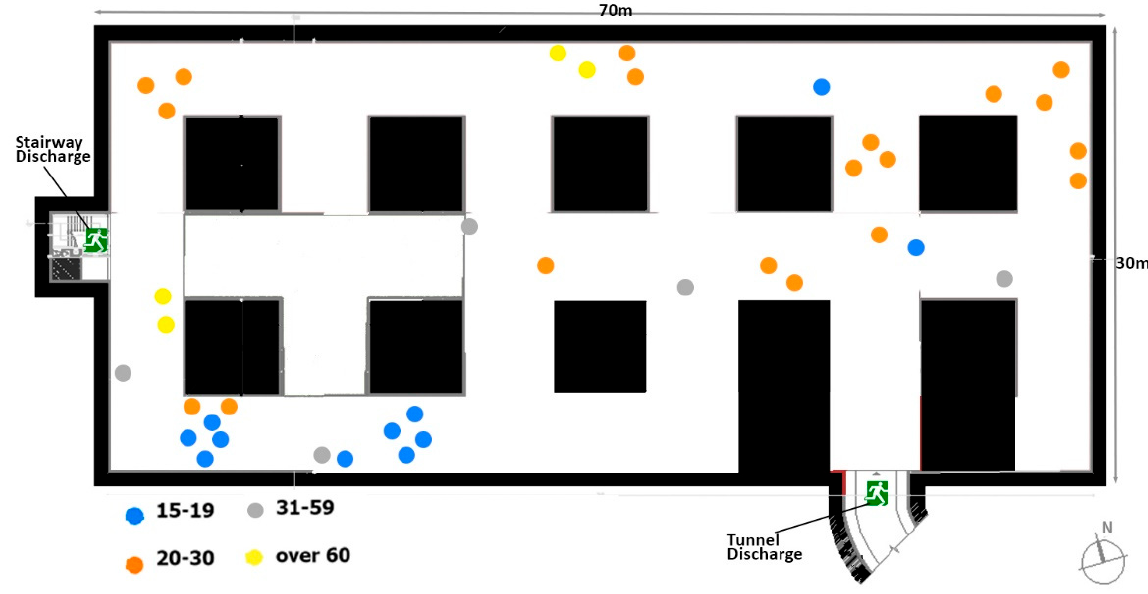
Figure 13. Participants distribution in the underground area during the first drill. During the second evacuation drill, participants gathered in the office space and were invited to evacuate the area only from the tunnel exit in the presence of dense smoke that simulated fire conditions (Figure 15). The machine produced non-irritant smoke